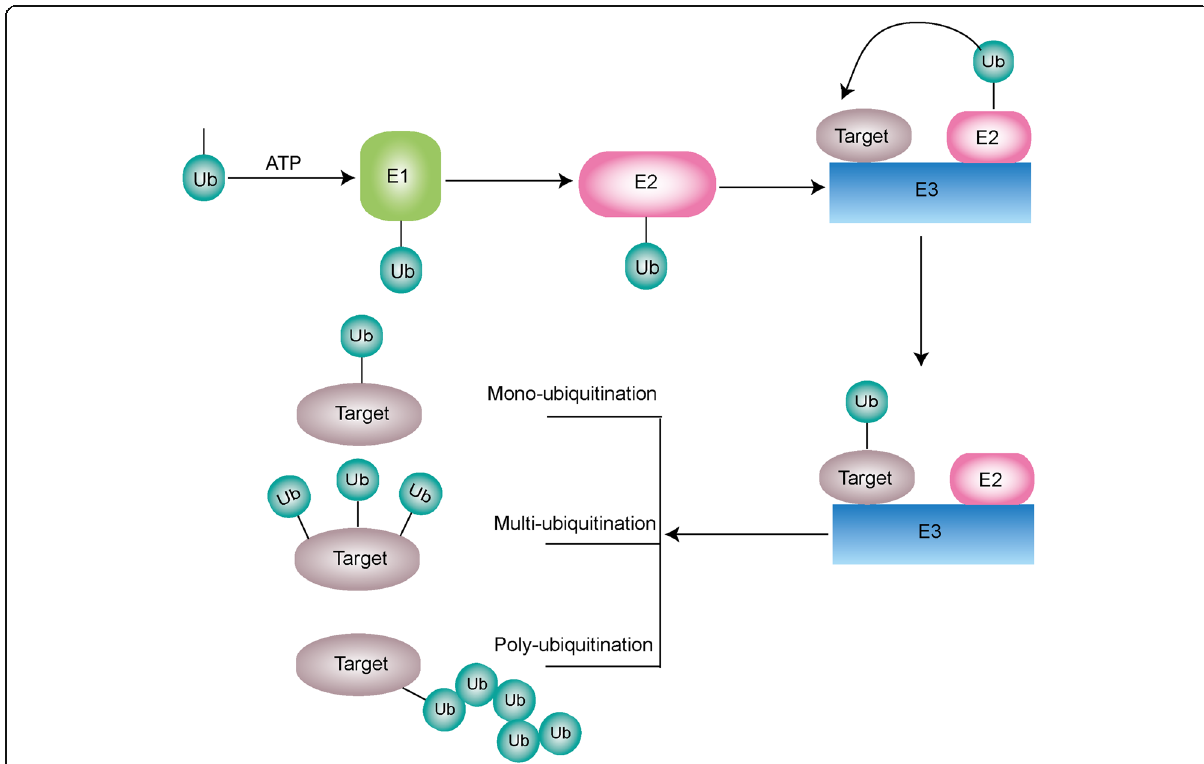
Fig. 2 Overview of the cascade process of ubiquitination. Ubiquitination is an important cascade process of posttranslational modification catalyzed by three key enzymes. Firstly, E1 catalyzes the activation of Ub through a thioester bond in an ATP dependent mechanism. Then, activated Ub is transferred to the active-site cysteine residue of an E2. The last step is mediated by an E3 ligase that recognizes the E2 complex and facilitates the transfer of Ub from E2 to the target substrate. Due to the different binding style of Ub on the target substrate, types of ubiquitination modification are divided into three: mono-ubiquitination, multi-ubiquitination and